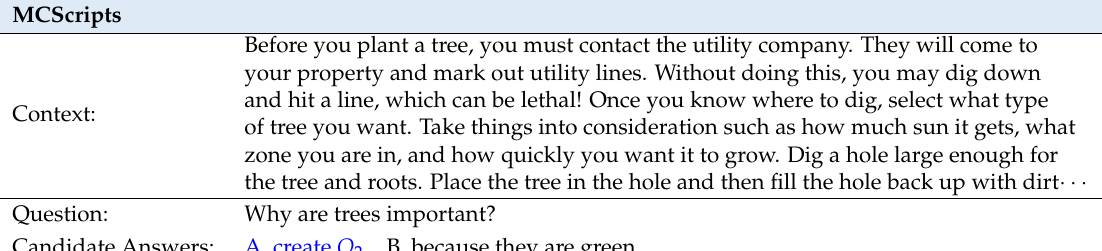
Table 10. Some Examples in